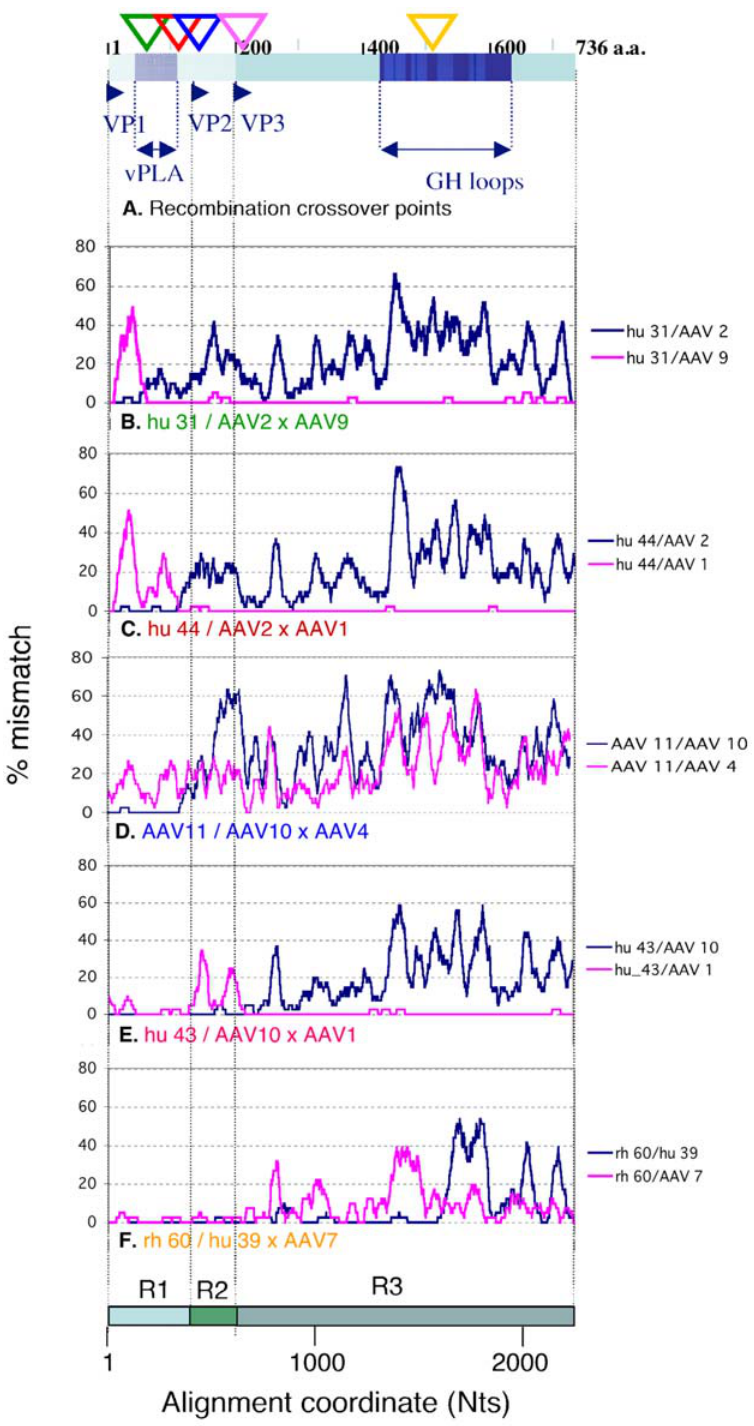
Figure 1. Profiles and cross-over points of novel recombination in the AAV cap gene. A. Schematic drawing of the cap gene products (VP1-3) with five recombination cross-over points inferred by LOHA analyses below (triangles colour-coordinated with Panels B-F) is shown. Viral phospholipase A and antigenic GH loop domains are indicated. B–F. Recombination profiles for representative combinations of 3 sequences (recombinant/parent 1 6 parent 2) were visualised by the LOHA analysis. Percent mismatch across a sliding window of 41 Nt positions between recombinant/parent pairs were plotted against the nucleotide positions along the multiple alignment with a step interval of 1 position. The x-axis also indicates three regions (R1-3) separately analysed in the following studies (see Fig 2 and 3).